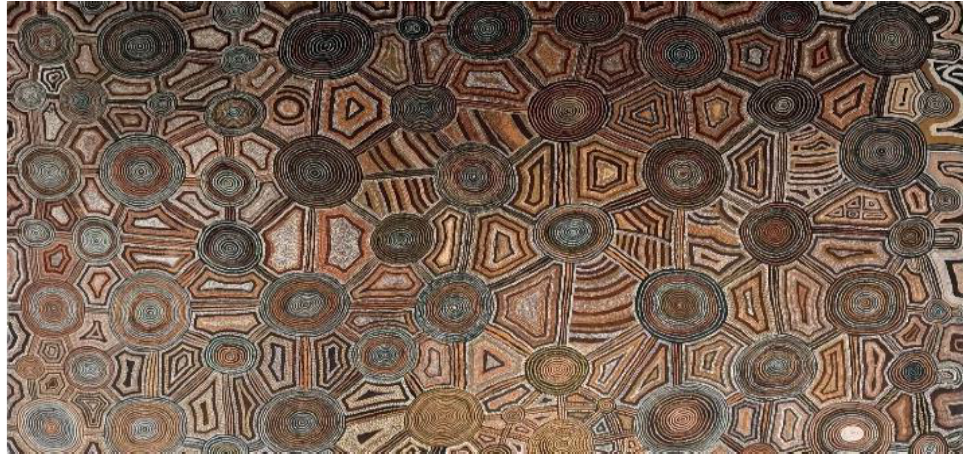
Figure 5. Uta Uta Tjangala. Untitled (Jupiter Well to Tjukula), 1979. © Estate of Uta Uta Tjangala. Licensed by Aboriginal Artists Agency Ltd.